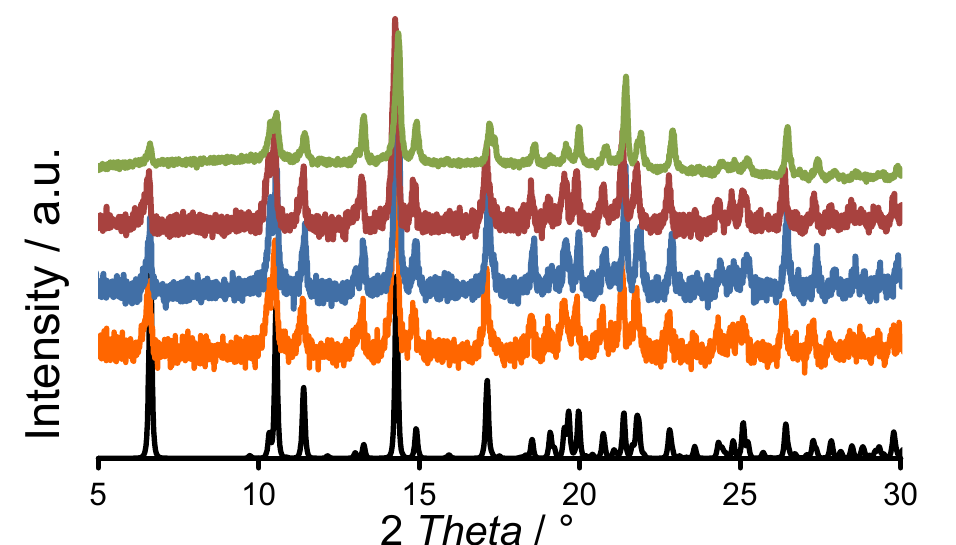
Figure 2. Powder diffraction patterns of coordination polymers 2 based on Ln cations. From top to bottom: Sm, Eu, Dy, and Y colored curves—the results of measurements of coordination compounds. Black—simulated spectrum of a phase diffraction pattern from a single crystal X-ray structural analysis of an Sm(III)-based polymer.